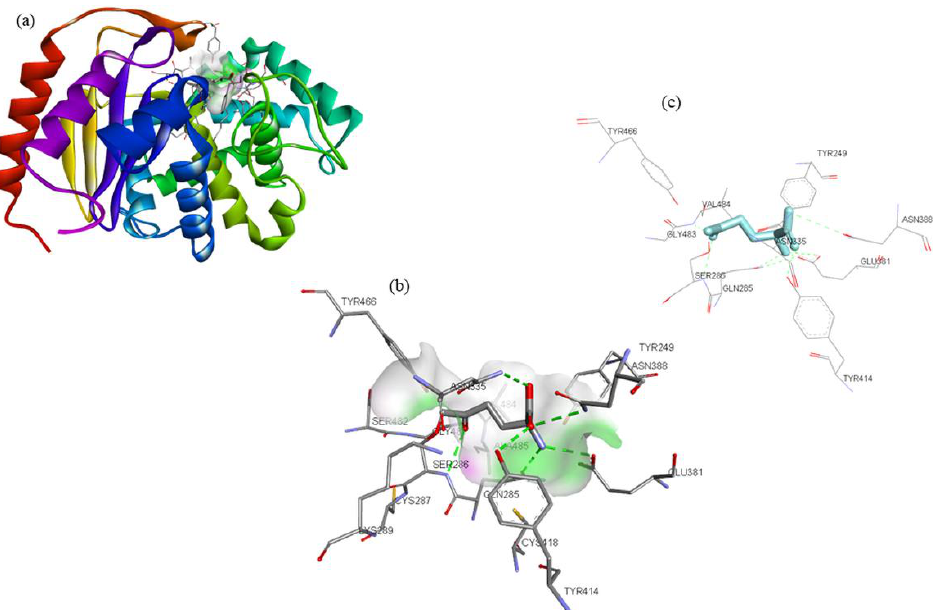
Figure 2. Visualization of ZINC32296657 (stick representation) in the binding pocket of GLS ( a ), interacting residues of GLS with ZINC32296657 ( b , c ).